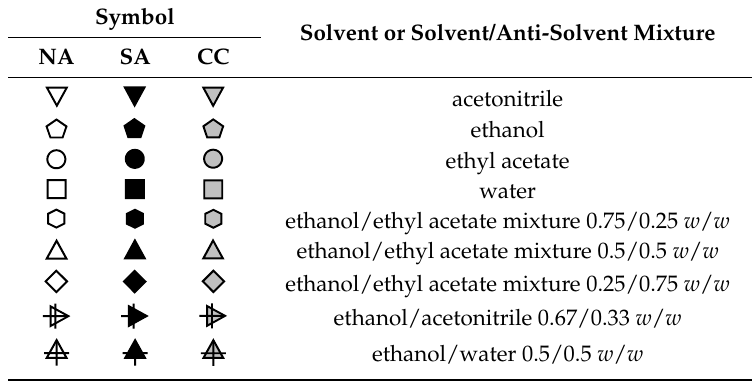
ethanol/water 0.5/0.5 w / w